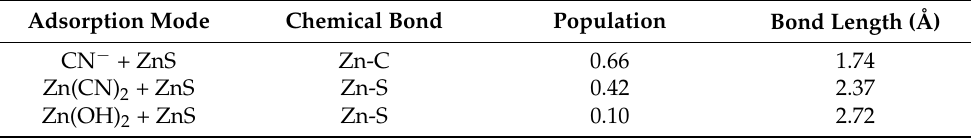
Table 3. Mulliken bond population of CN − , Zn(CN) 2 , and Zn(OH) 2 . Adsorption